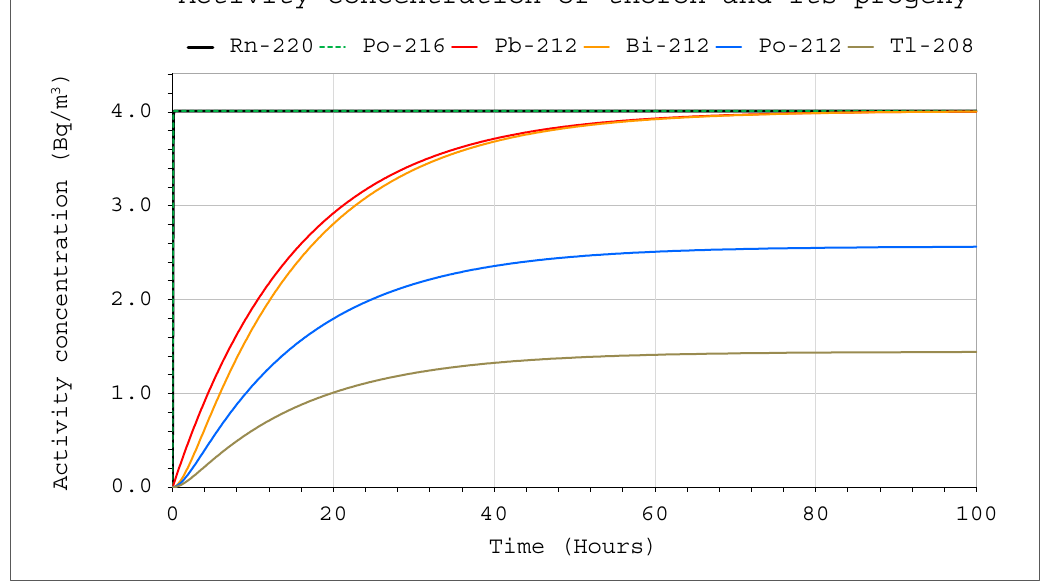
Figure 7. Activity concentration inside the system for the following conditions: inflow of thoron throughout the analyzed period at a rate of E 1 = 1 Bq/s, V = 20 m 3 , C oi = 0. No filtration system was operating inside.